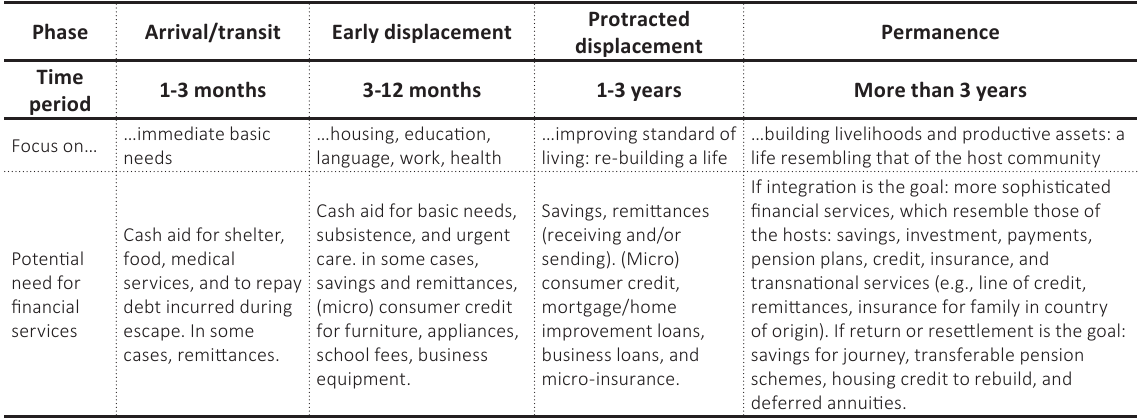
Table 1. Gradual phase integration of FDPs into economic mainstream Source: Global Partnership for Financial Inclusion Policy Report